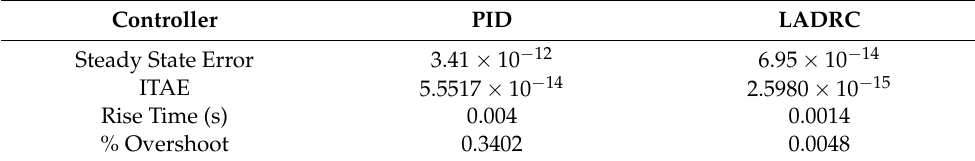
Figure 7. Melt pool area tracking by PID and LADRC controller.